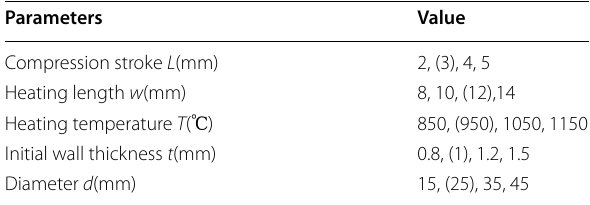
Table 2 Values of the forming